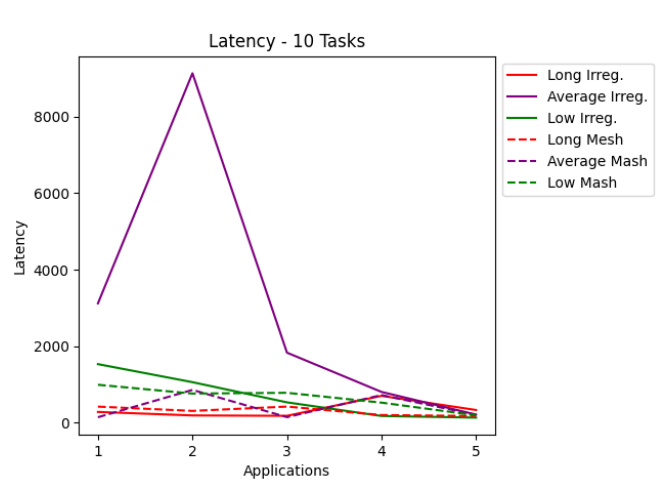
Figure 6. Latency for applications with 10 tasks.